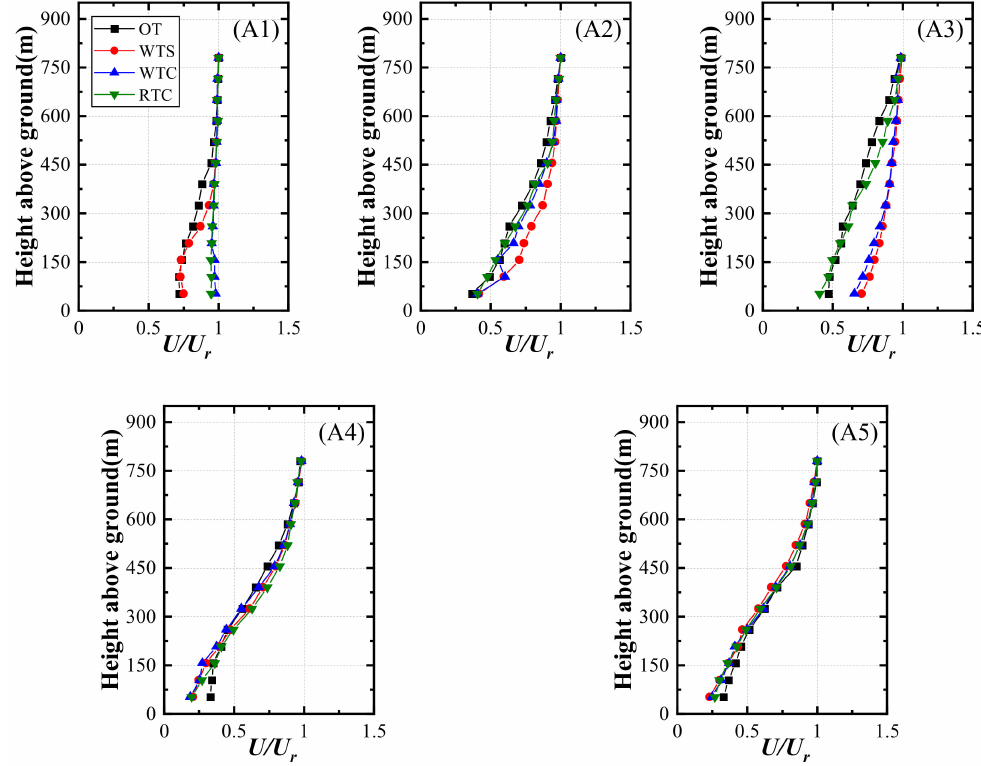
Figure 4. Profiles of mean velocity at measurement locations: (A1) location A1; (A2) location A2; (A3) location A3; (A4) location A4; (A5) location